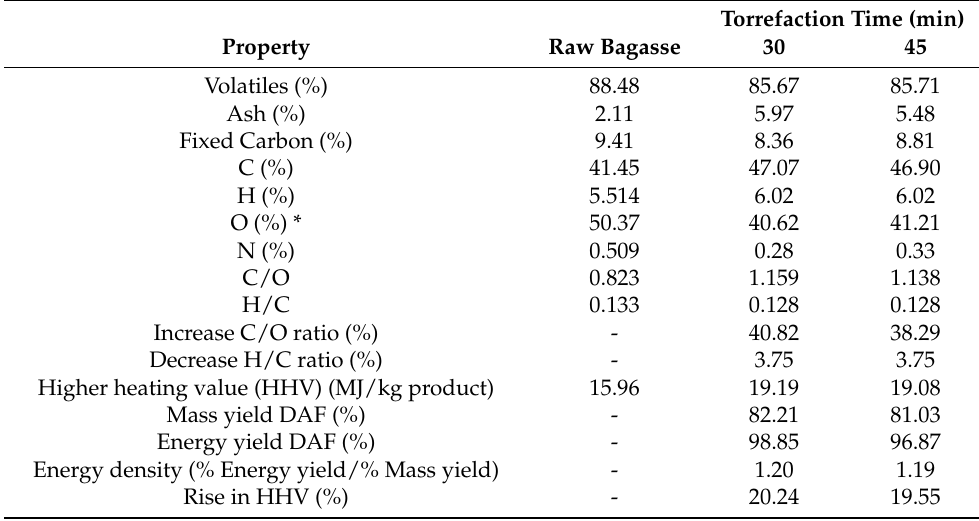
Table 4. The proximal and ultimate composition of torrefied sugarcane bagasse at 230 ◦ C.